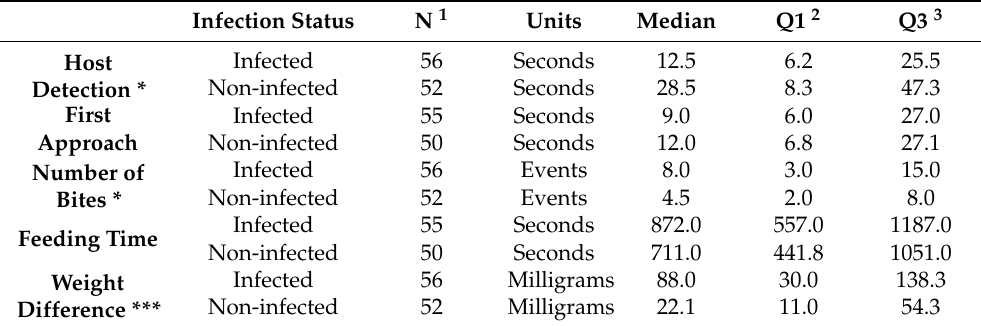
Table 1. Summary values of the feeding activity according to Trypanosoma cruzi infection status of Triatoma infestans .